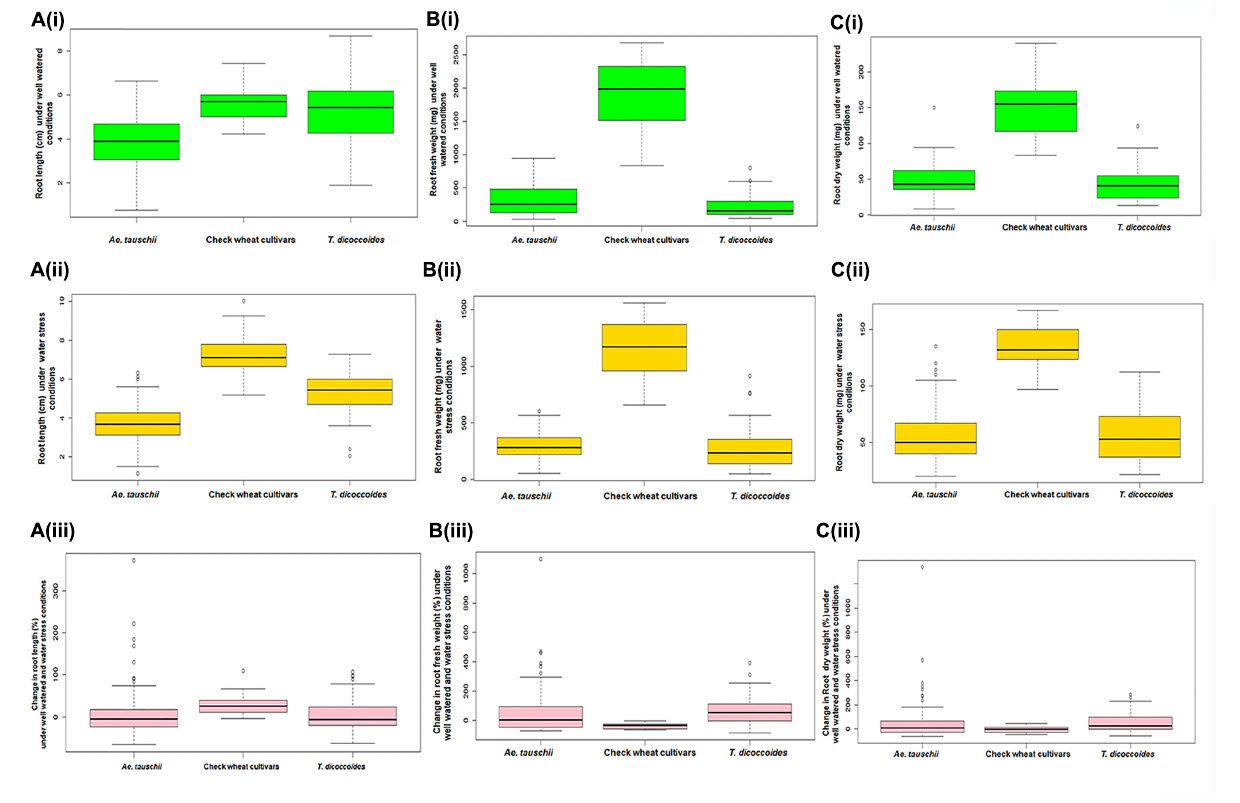
Table S5 ), whereas highest water stress-mediated induction (197.06%) was observed in an Ae. tauschii accession (9803) ( Table 3 and Supplementary Table S5 ). In case of T. dicoccoides , the maximum increase in root length (97.47% in accession 5364) was higher than the greatest increase for this trait observed in cultivated set (85% in PDW-314) ( Figure 3A